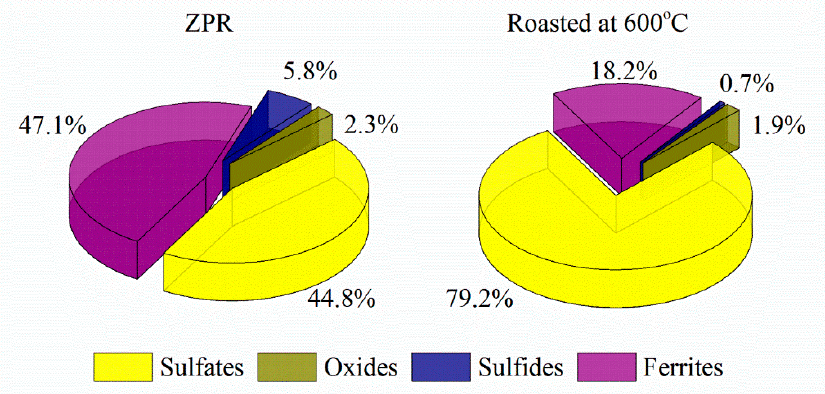
Figure 9. Copper phase distribution in ZPR and in the roasted sample obtained at 600 °C after 180 min of the roasting with the addition of 48% Fe 2 (SO 4 ) 3 ∙ 9H 2 O to 100% ZPR.